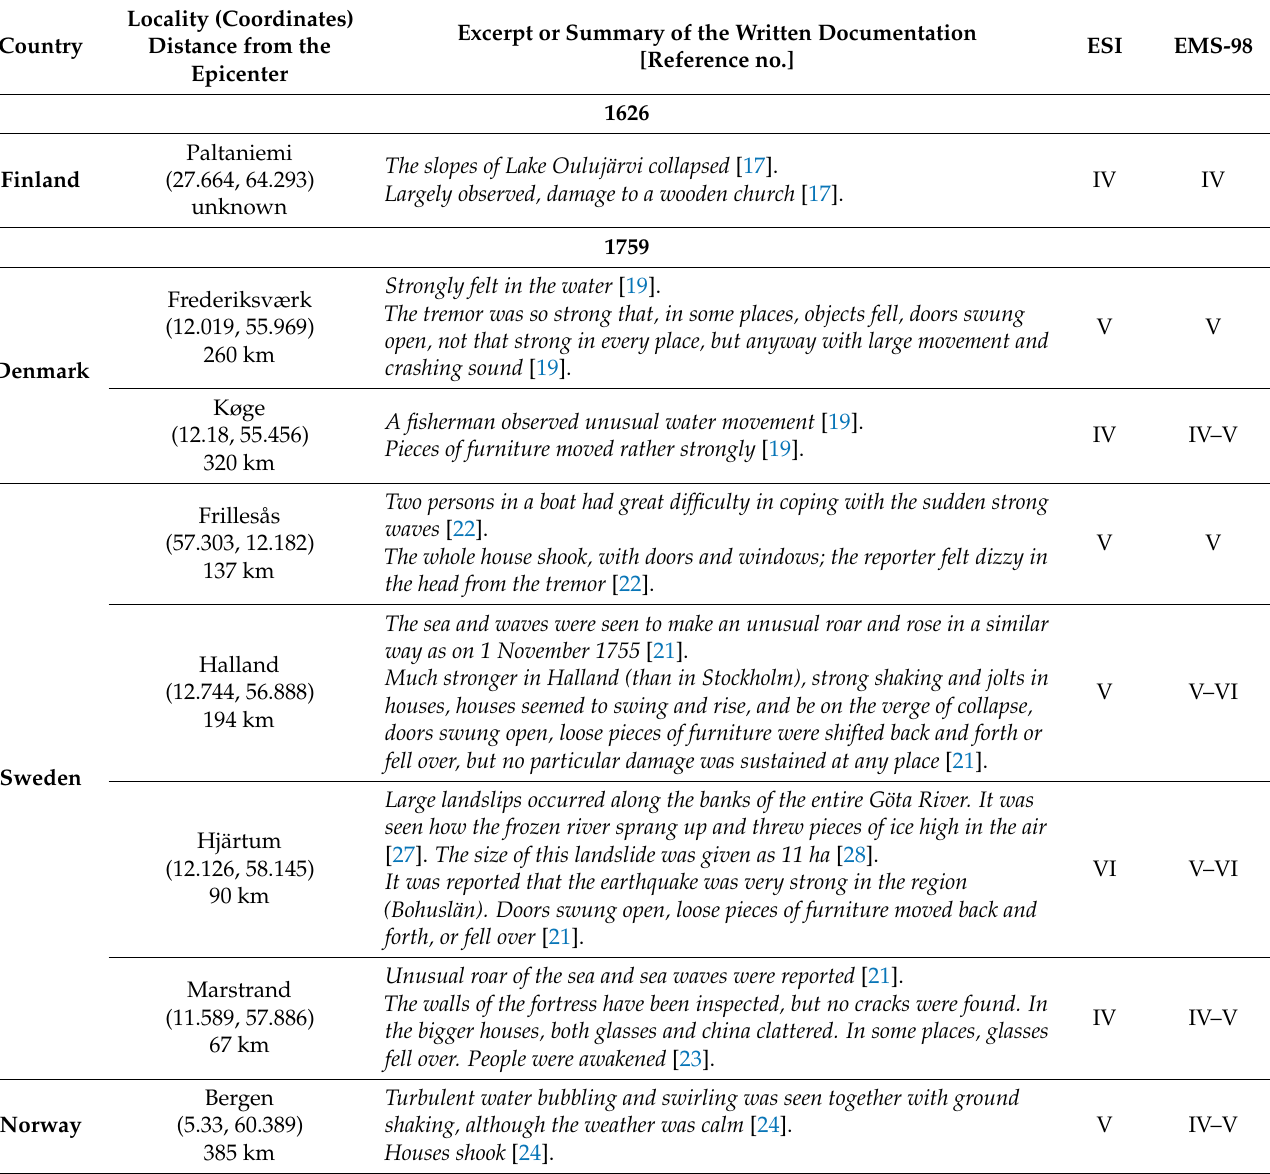
Table 1. Environmental Seismic Intensities (ESIs) and European Macroseismic Scale (EMS-98) intensities for the earthquakes of 1626, 1759, and 1819 in Fennoscandia, northern Europe (the coordinates are given as longitude ◦ E and latitude ◦ N).